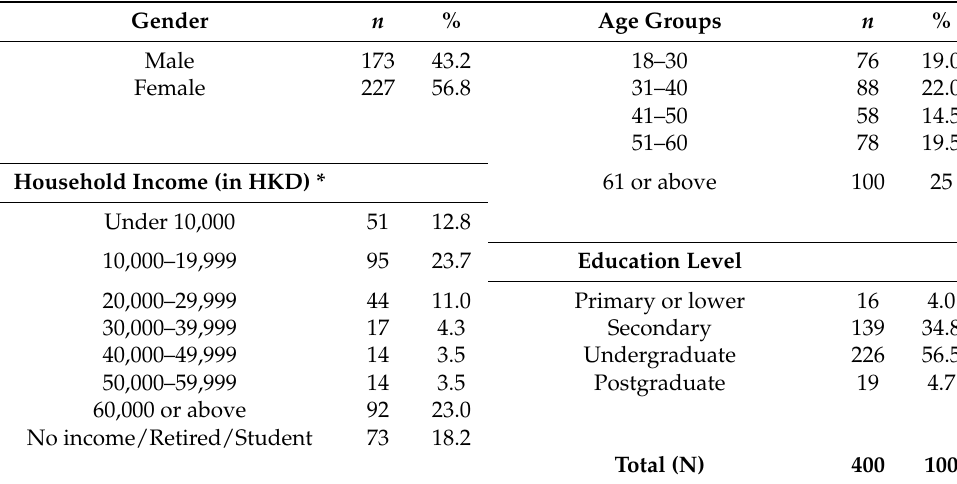
Table 1. Demographic characteristics of